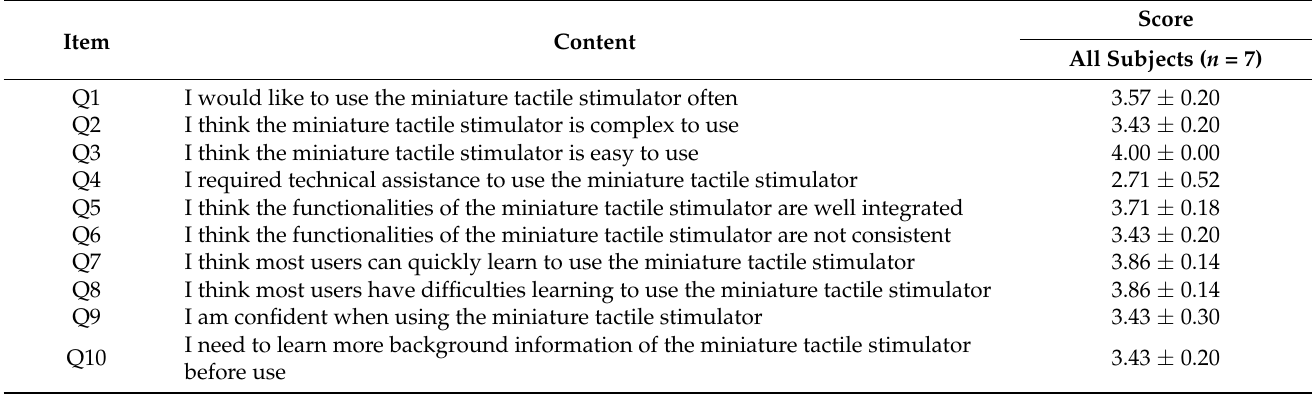
Table 5. SUS score obtained from the